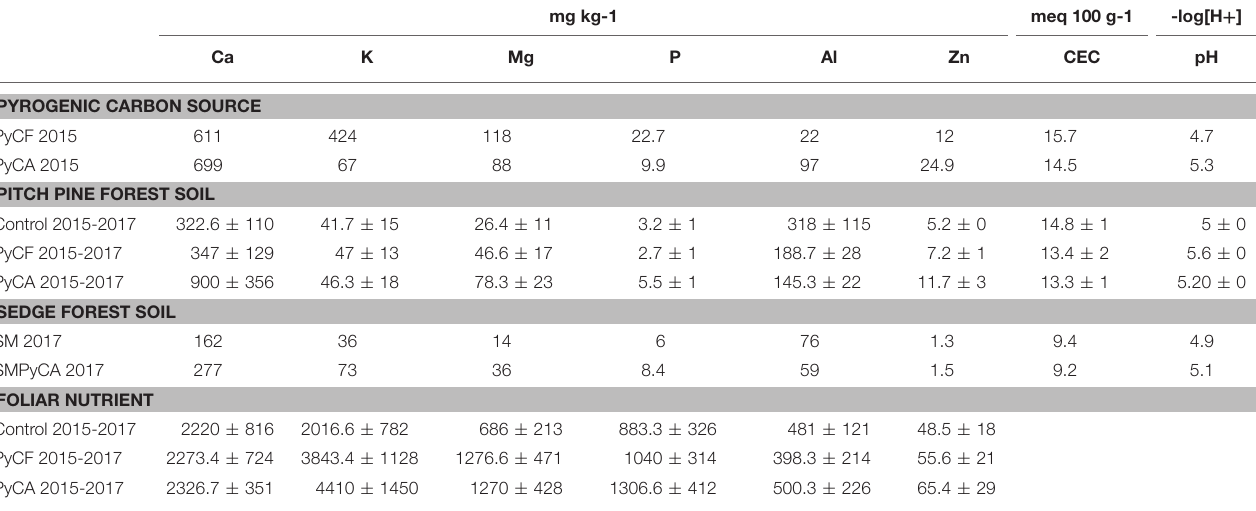
TABLE 4 | PyC, Pitch pine forest soil, Sedgemeadow forest soil, and Foliar Nutrient data were extracted, analyzed, and reported between 2015 and 2017 using mean ±